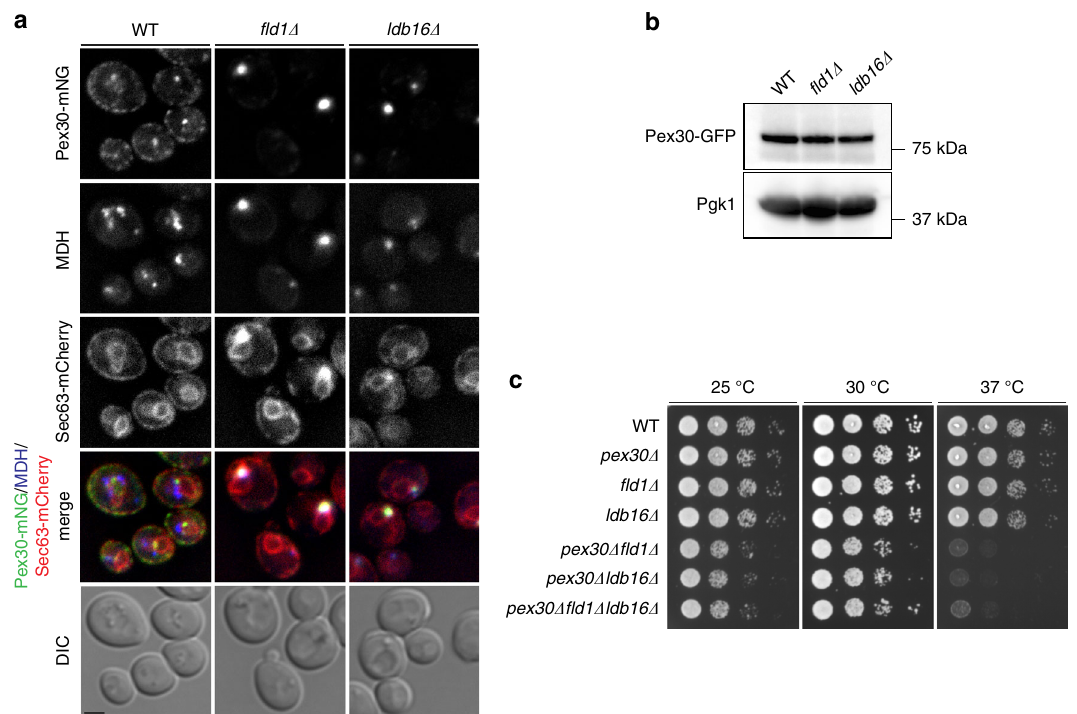
Fig. 1 Pex30 is localized to LD proximal regions in seipin mutants. a Localization of endogenous Pex30 tagged with monomeric Neon Green (Pex30-mNG) in WT, fl d1 Δ , and ldb16 Δ cells. Endogenous Sec63 was tagged with mCherry and used as an ER marker. LDs were stained with the neutral lipid dye MDH. Bar 2 µ m. b Levels of endogenous GFP-tagged Pex30 in WT, fl d1 Δ , and ldb16 Δ cells. Whole-cell extracts were separated by SDS-PAGE and analyzed by western blotting. Pex30-GFP and Pgk1, used as loading control, were detected with anti-GFP and -Pgk1 antibodies, respectively. c Tenfold serial dilutions of cells with the indicated genotype were spotted on YPD media and incubated at 25 °C, 30 °C, or 37 °C for 2